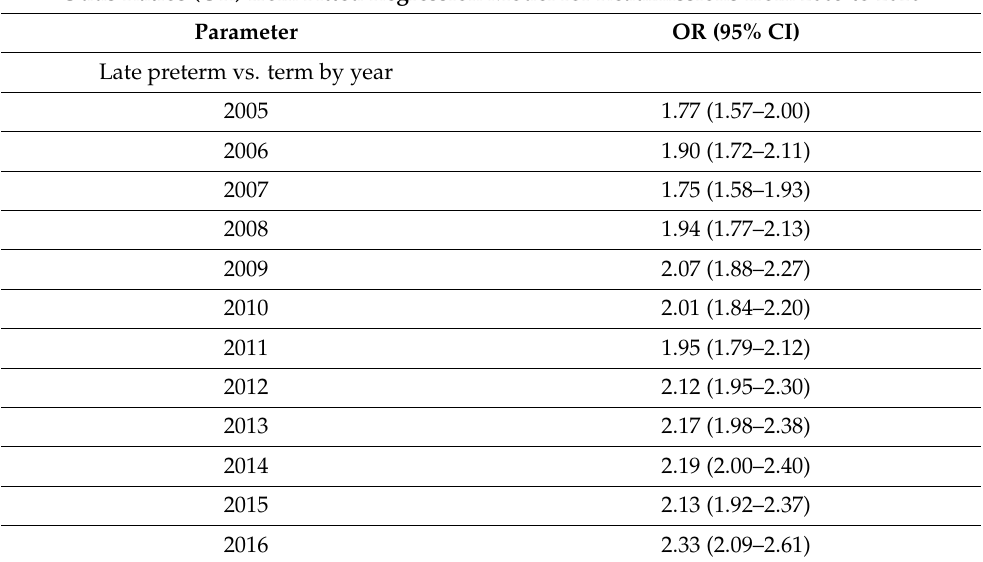
Figure 4. Readmission rates and costs for late preterm and term infants from 2005–2016. Panel ( A ) displays estimated probabilities indicated by black lines and 95% confidence intervals by gray regions from fitted regression model for readmissions. Panel ( B ) displays estimated mean costs indicated by black lines and 95% confidence intervals by gray regions from fitted regression model for readmission costs. Table 4. Odds ratios from fitted regression model for readmissions from 2005 to 2016. Odds Ratios (OR) from Fitted Regression Model for Readmissions from 2005 to